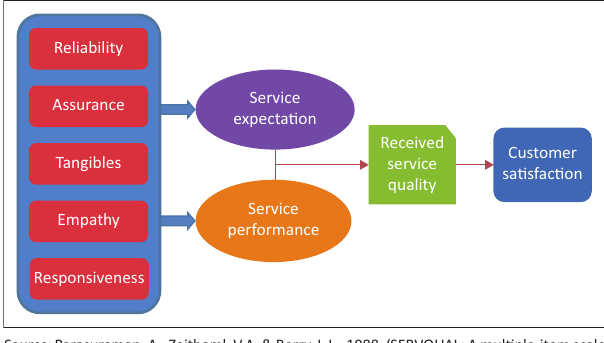
FIGURE 1: The SERVQUAL